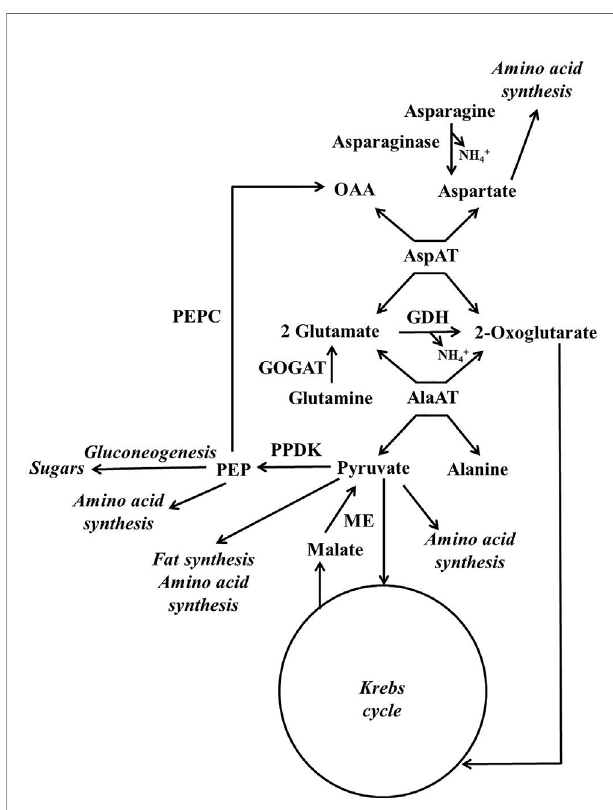
FIGURE 3 | Simpli fi ed scheme outlining the major pathways involved in the metabolism of nitrogenous compounds and malic and citric acids in fruits and seeds of stone fruits (based on Walker et al., 2018). AlaAT = alanine aminotransferare; AspAT = aspartate aminotransferare; GDH = glutamate dehydrogenase; GOGAT = glutamate synthase also known as glutamine oxoglutarate aminotransferase; ME = malic enzyme; OAA = oxalacetate; PEP = phosphoenolpyruvate; PEPC = phosphoenolpyruvate carboxylase; PPDK = pyruvate orthophosphate